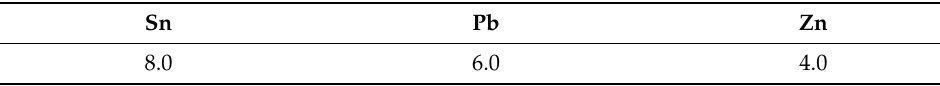
Table 4. Chemical compositions of Cu–8%Sn